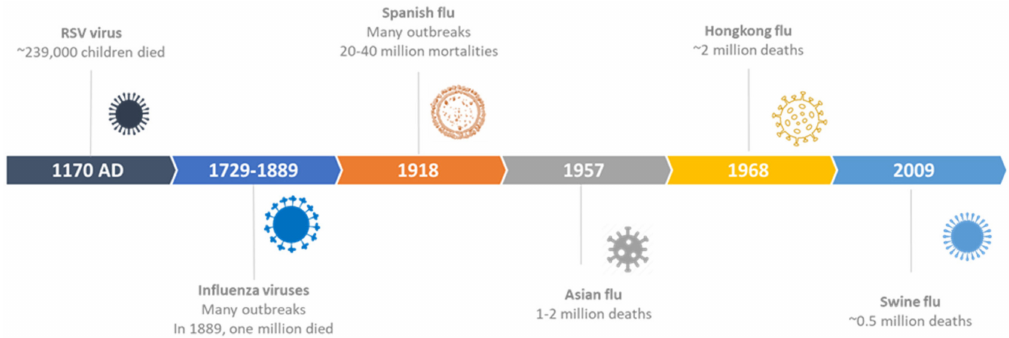
Figure 1. Pandemics caused by some of the respiratory tract-associated viruses and resulting